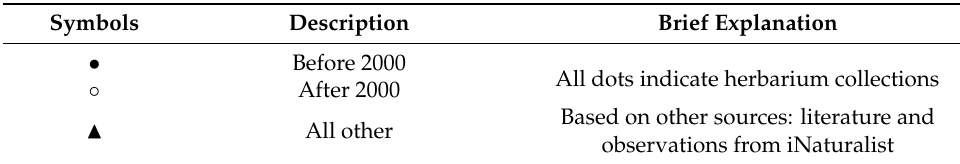
Table 1. Mapping symbols used in the distribution maps. Symbols